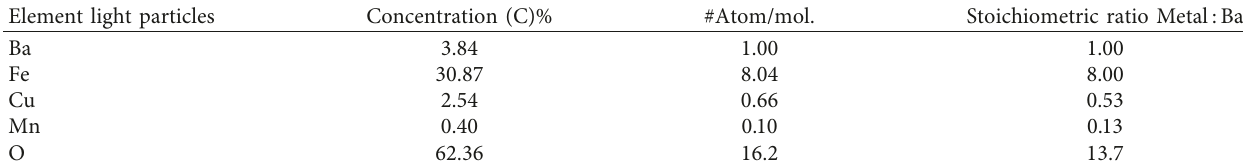
� 0) sample. 3 [Cu 0.8 − x Zn x Mn 0.2 ] 2 Fe 24 O 41 ( x � 0). 3 [Cu 0.8 − x Zn x Mn 0.2 ] 2 Fe 24 O 41 ( x